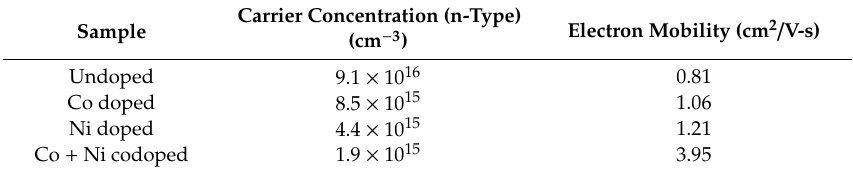
Table 3. Hall measurements of undoped, Co doped, Ni doped, and Co + Ni codoped ZnO